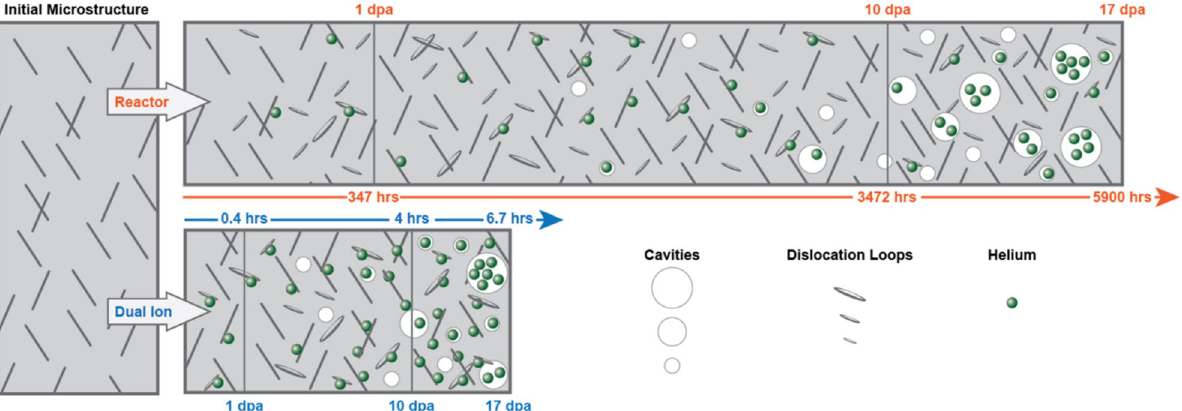
Figure 6. Schematic of the time-dependent helium trapping and release behavior under reactor and ion irradiation conditions. With the higher damage rate of dual ion irradiation compared to reactor irradiation, more helium becomes trapped at microstructural features other than cavities requiring additional helium to be injected.